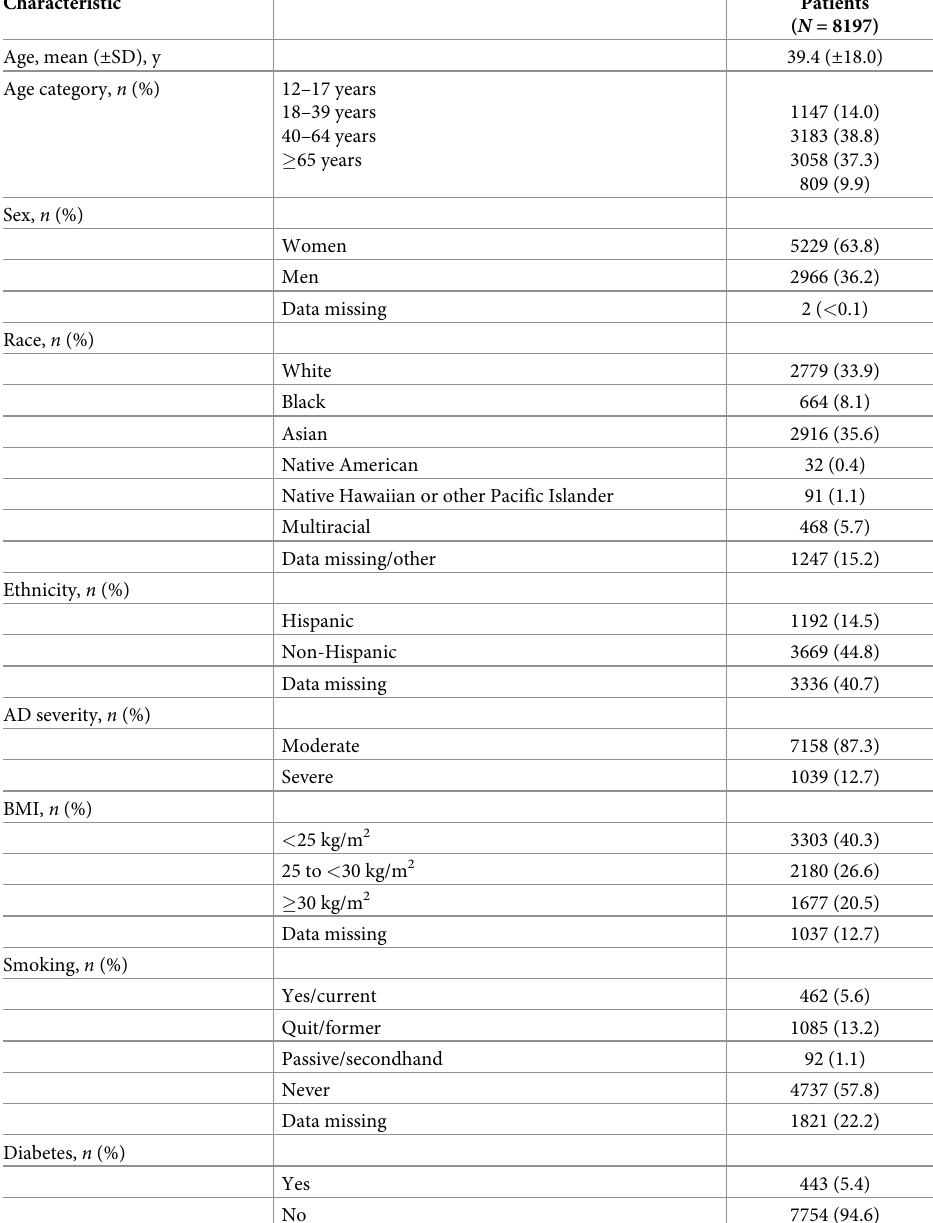
Table 1. Demographic and baseline characteristics of the cohort of KPNC health plan members (2007–2018) aged � 12 years with moderate-to-severe atopic